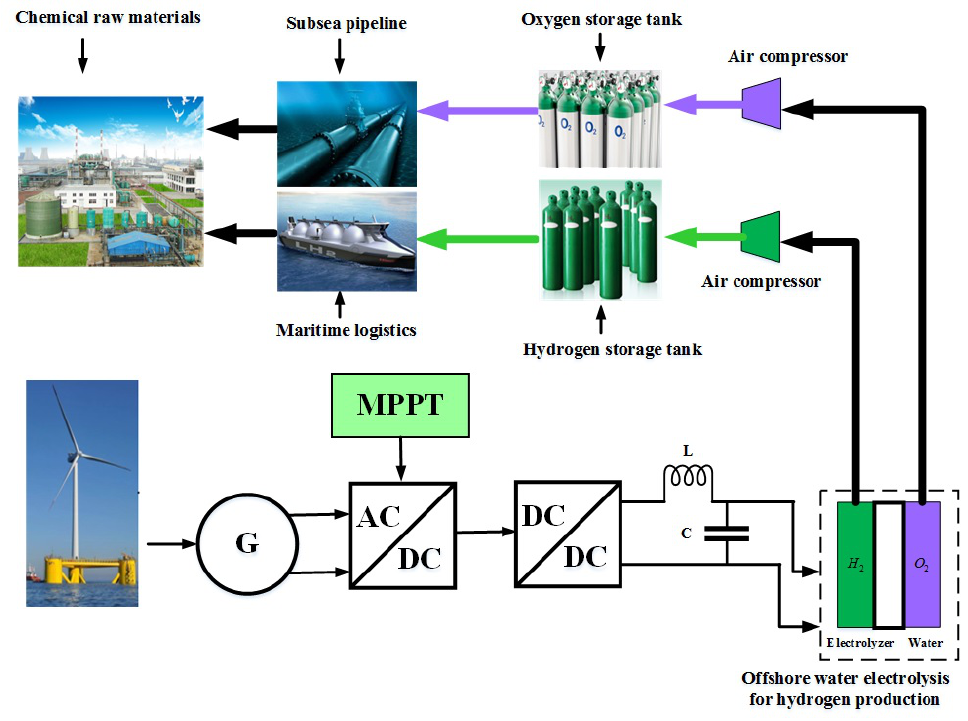
Figure 11. The description of the non-grid-connected hydrogen production and logistics of floating offshore wind